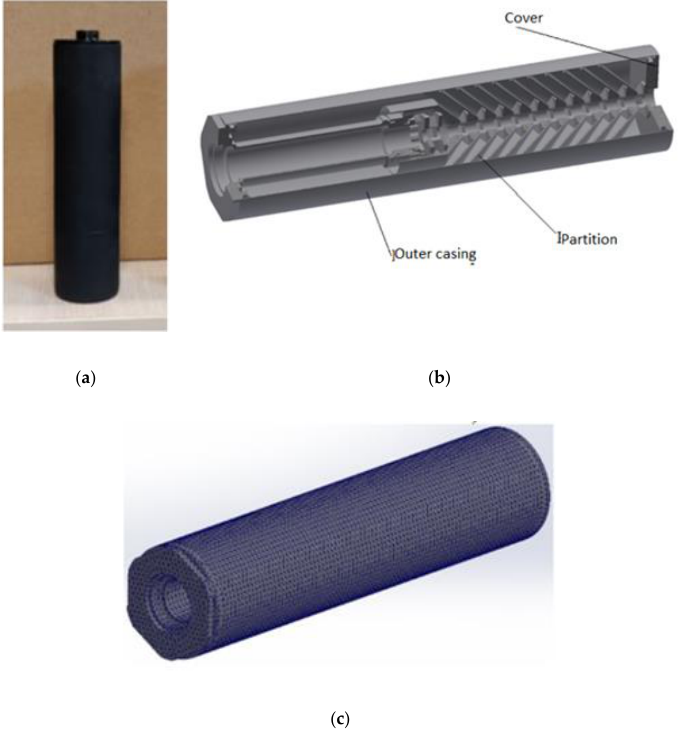
Figure 1. The total view ( a ), 3D model ( b ) and the silencer finite element grid ( c ). The sound pressure p is calculated using the Helmholtz Equation (1) [46].